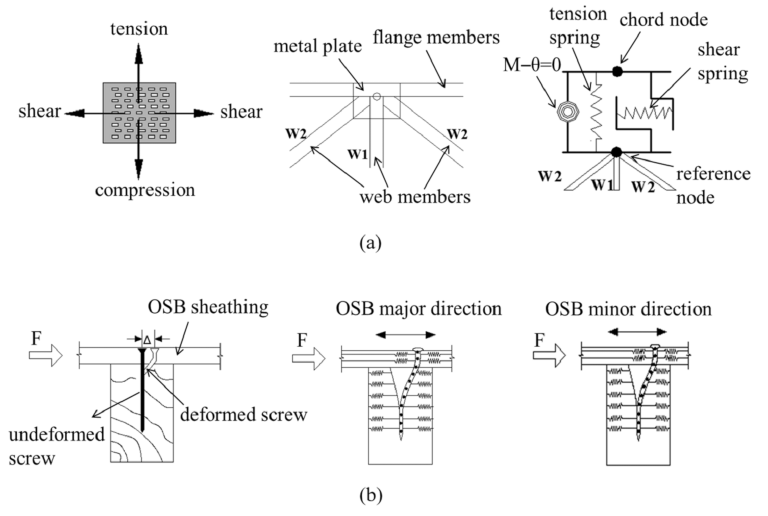
Figure 7. Spring models for the metal plate connections ( a ) and the screwed connections ( b